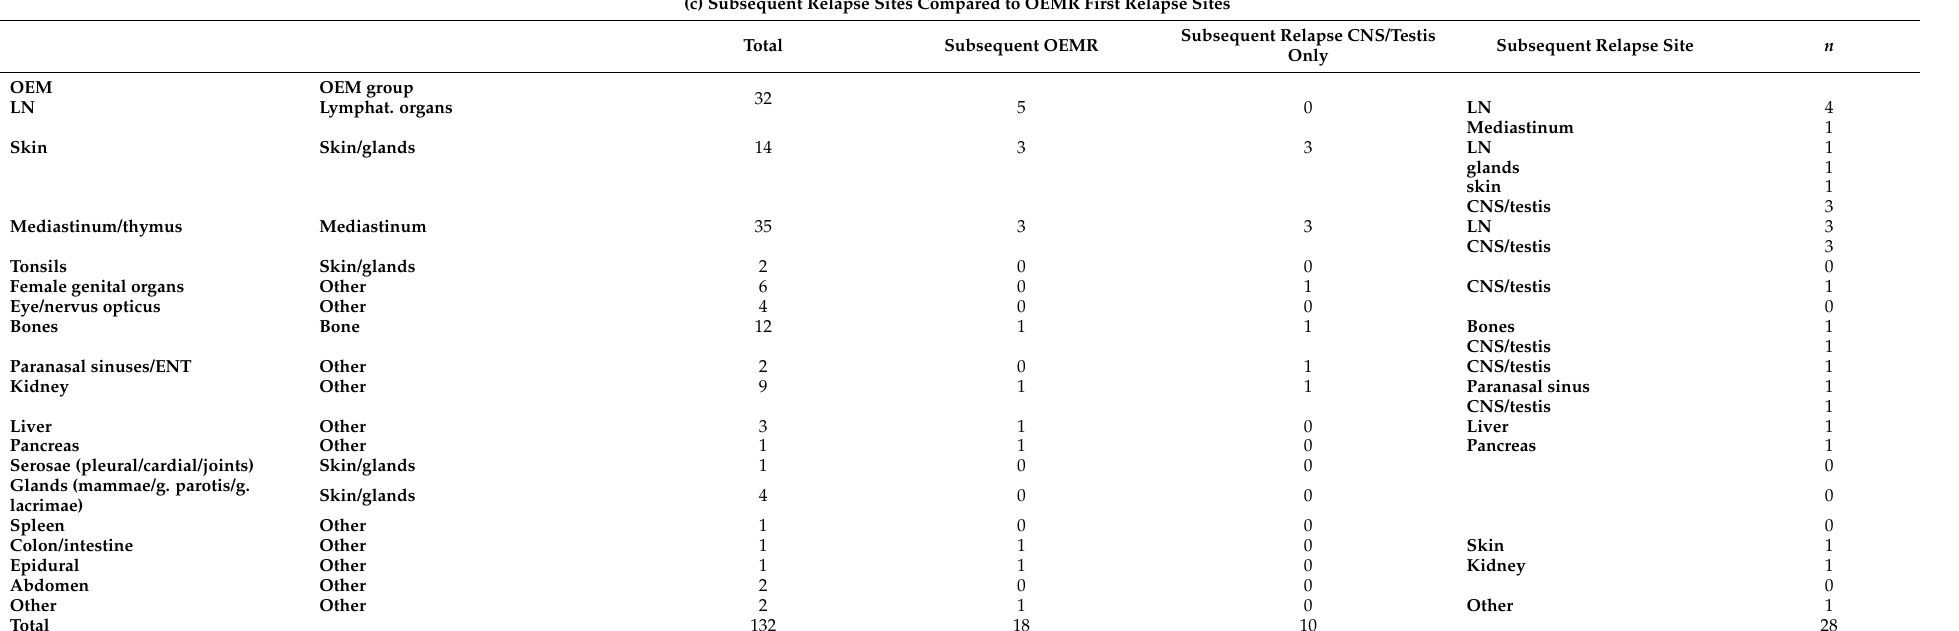
Legend to Table 3: * Pearson/chi-squared including Yate’s continuity correction; due to the exploratory character no correction for multiple testing has been performed. Missing values excluded. Abbreviations: BM, bone marrow; (C)CR, (continued) complete remission; IBM, isolated bone marrow; CBM, combined bone marrow; IEM, isolated extramedullary; LN, lymph node; CNS, central nervous system; OEM, other extramedullary; w/o,